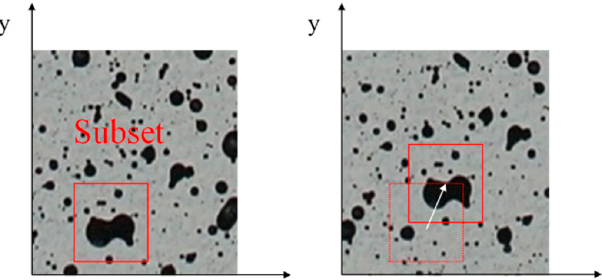
Figure 1. Process for calculation of deformation by DIC. ( a ) Reference image, ( b ) Deformed image.